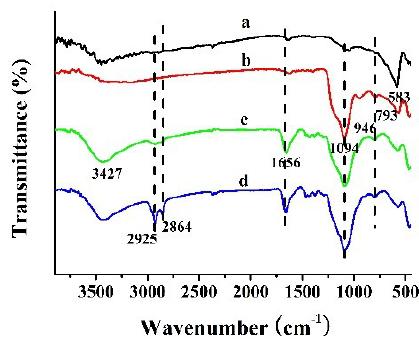
Figure 1. FTIR spectra of ( a ) Fe 3 O 4 ; ( b )Fe 3 O 4 @SiO 2 ; ( c )Fe 3 O 4 @CTS/SiO 2 composite; and ( d ) Fe 3 O 4 @CTS/SiO 2 -C 12 composite.